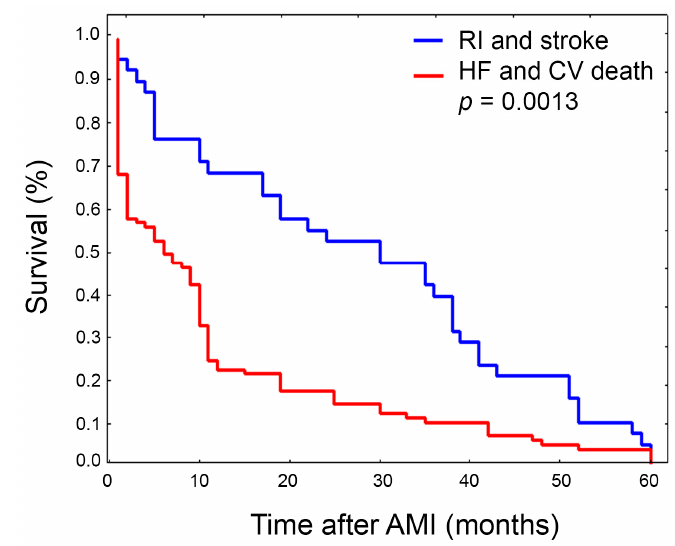
Figure 5. Plots of Kaplan-Meier survival analysis estimated after AMI according to different kinds of MACE at five-year follow-up. Cardiovascular (CV) death and heart failure (HF) combined together (red line), stroke and recurrent non-fatal ischemic events (RI) combined together (blue line). Survival significantly differed between subgroups ( p = 0.0013). Table 3. Logistic regression for composite–MACE and MACE–recurrence.